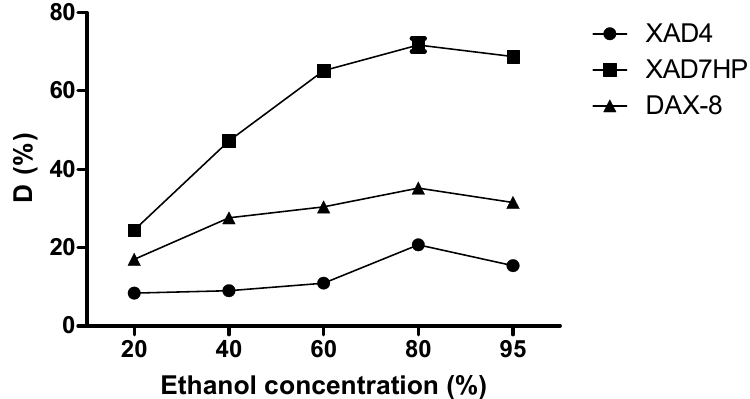
Figure 4. E ff ect of ethanol concentration on desorption ratio ( D ) of OPL total flavonoids from the selected MARs.